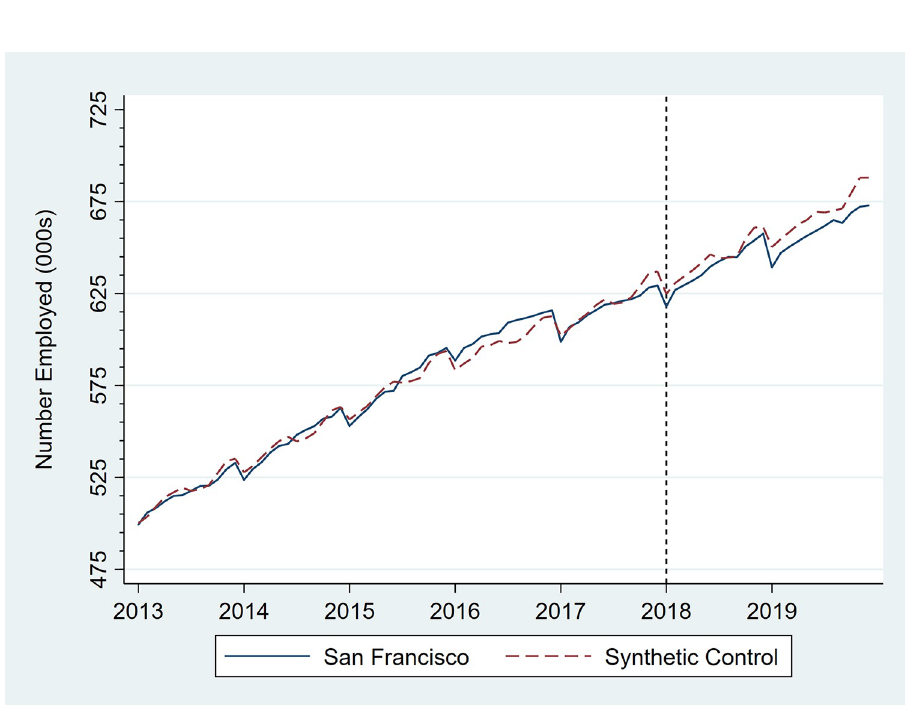
Fig 2. Number of persons employed in the private sector, San Francisco, CA, and its synthetic control, monthly, January 2013 through December 2019.